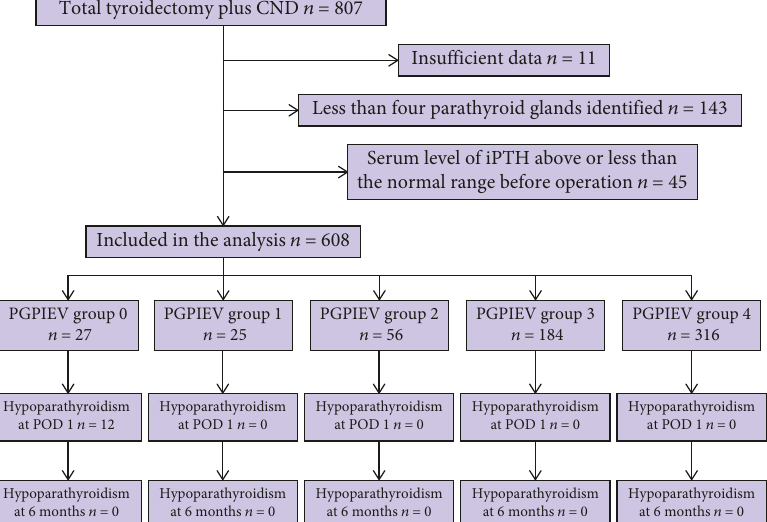
Figure 2: Flowchart for the study of parathyroid gland fine-needle pricking tests to predict parathyroid function. The PGPIEV group indicates the number of in situ preserved parathyroid glands with excellent vascularity (see text for details). Hypoparathyroidism was defined by an intact parathyroid hormone level below 15ng/l. CND, central neck dissection; POD, postoperative